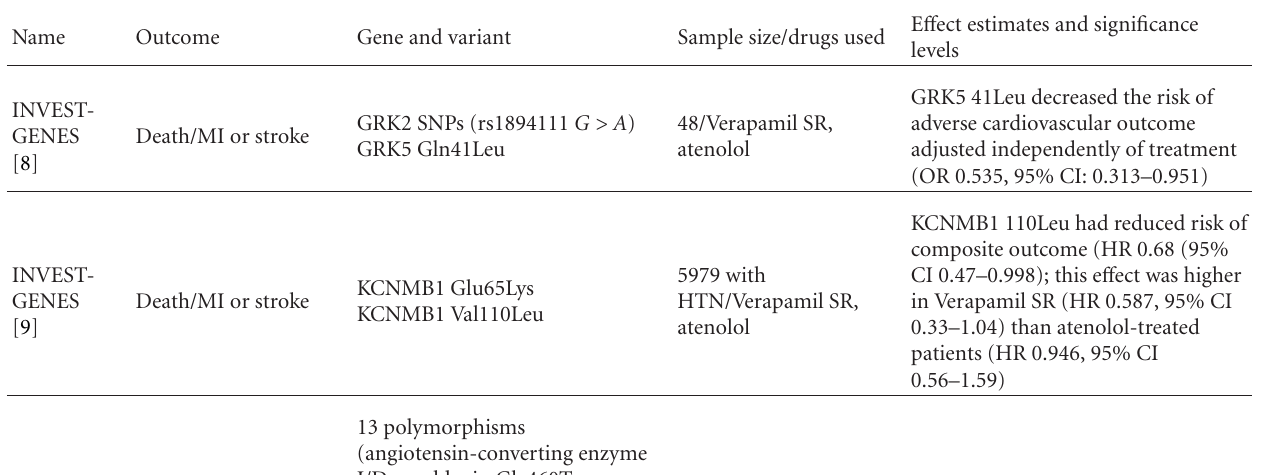
Table 1: Antihypertensive